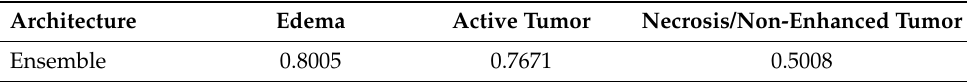
Table 7. Dice for Different Types of Tumor Tissues Obtained by the Ensemble Model.